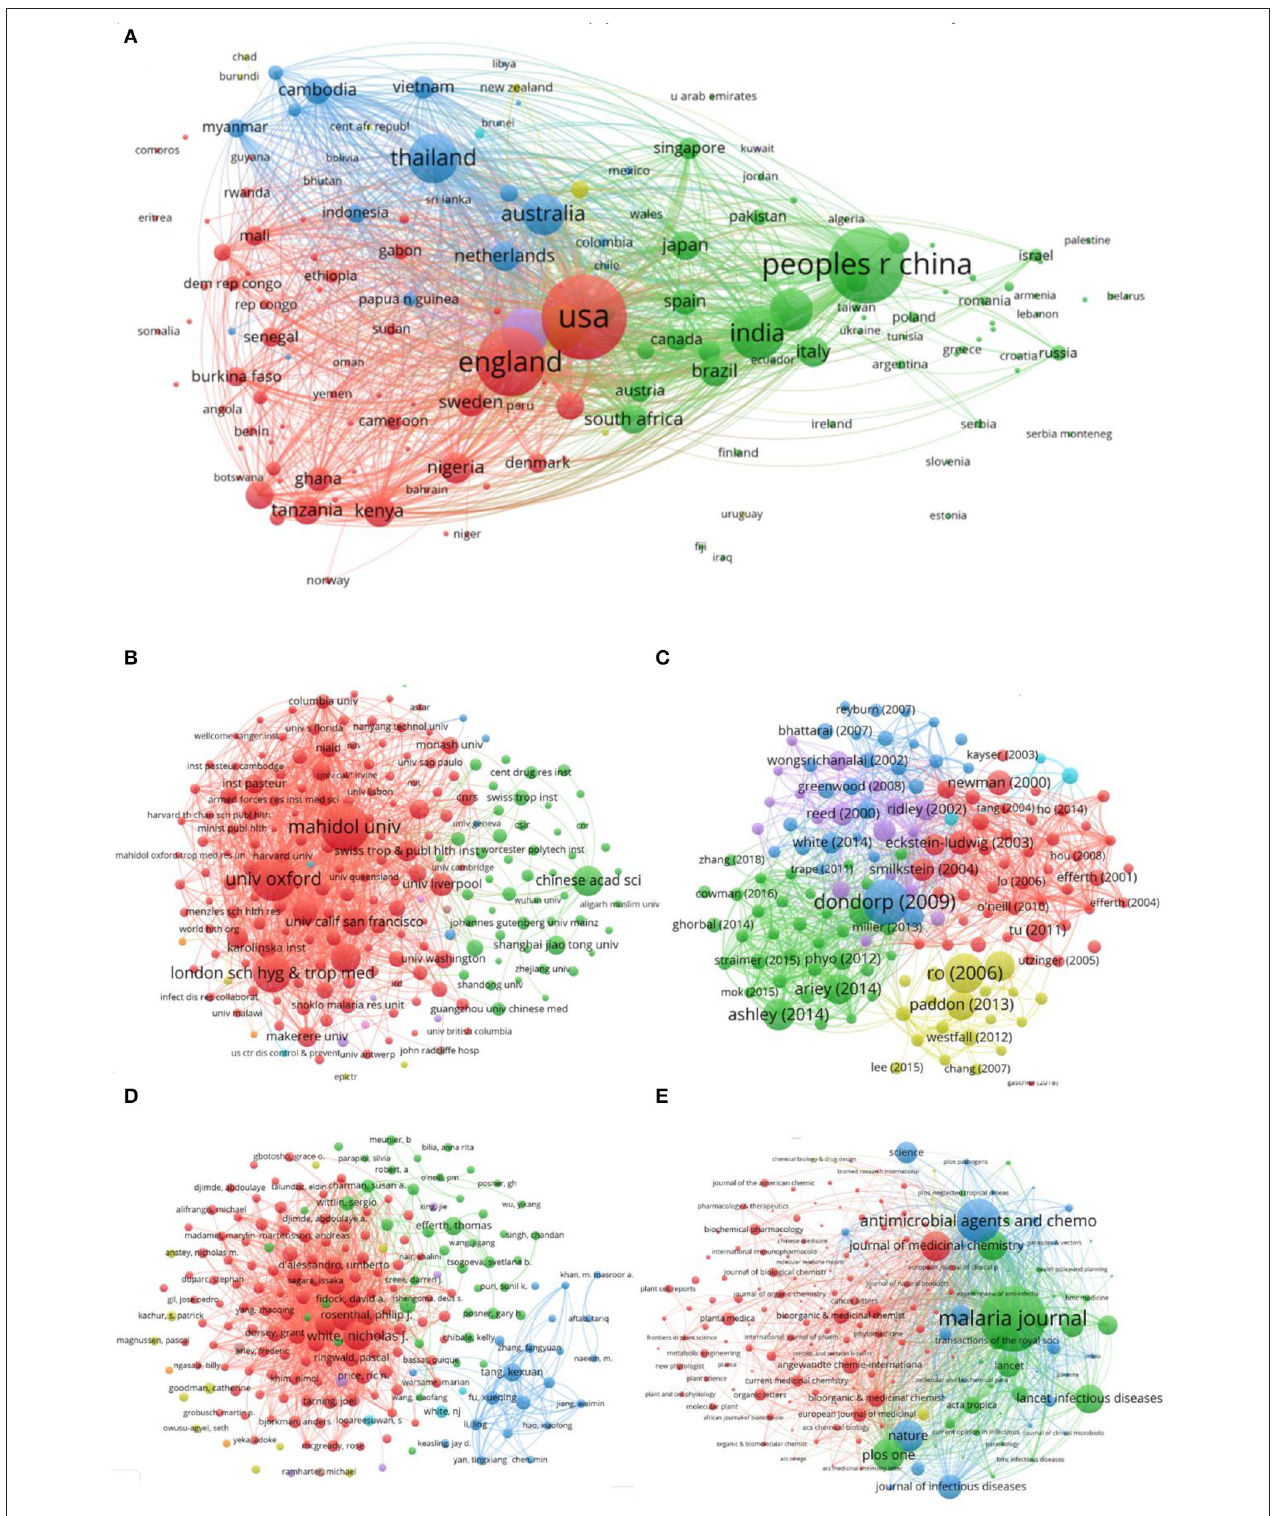
FIGURE 8 | Bibliographic coupling analysis. (A) Network of co-occurrence of countries. (B) Network of co-occurrence of affiliations. (C) Network of co-occurrence of documents. (D) Network of co-occurrence of authors. (E) Network of co-occurrence of journals.